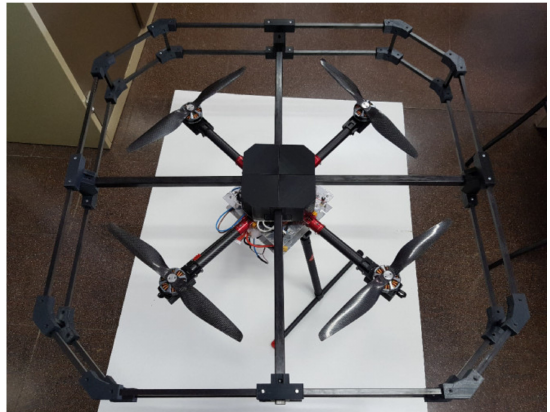
Figure 3. Prototype UAV platform developed as a base for a sample collector UAV part of the UAV sensing